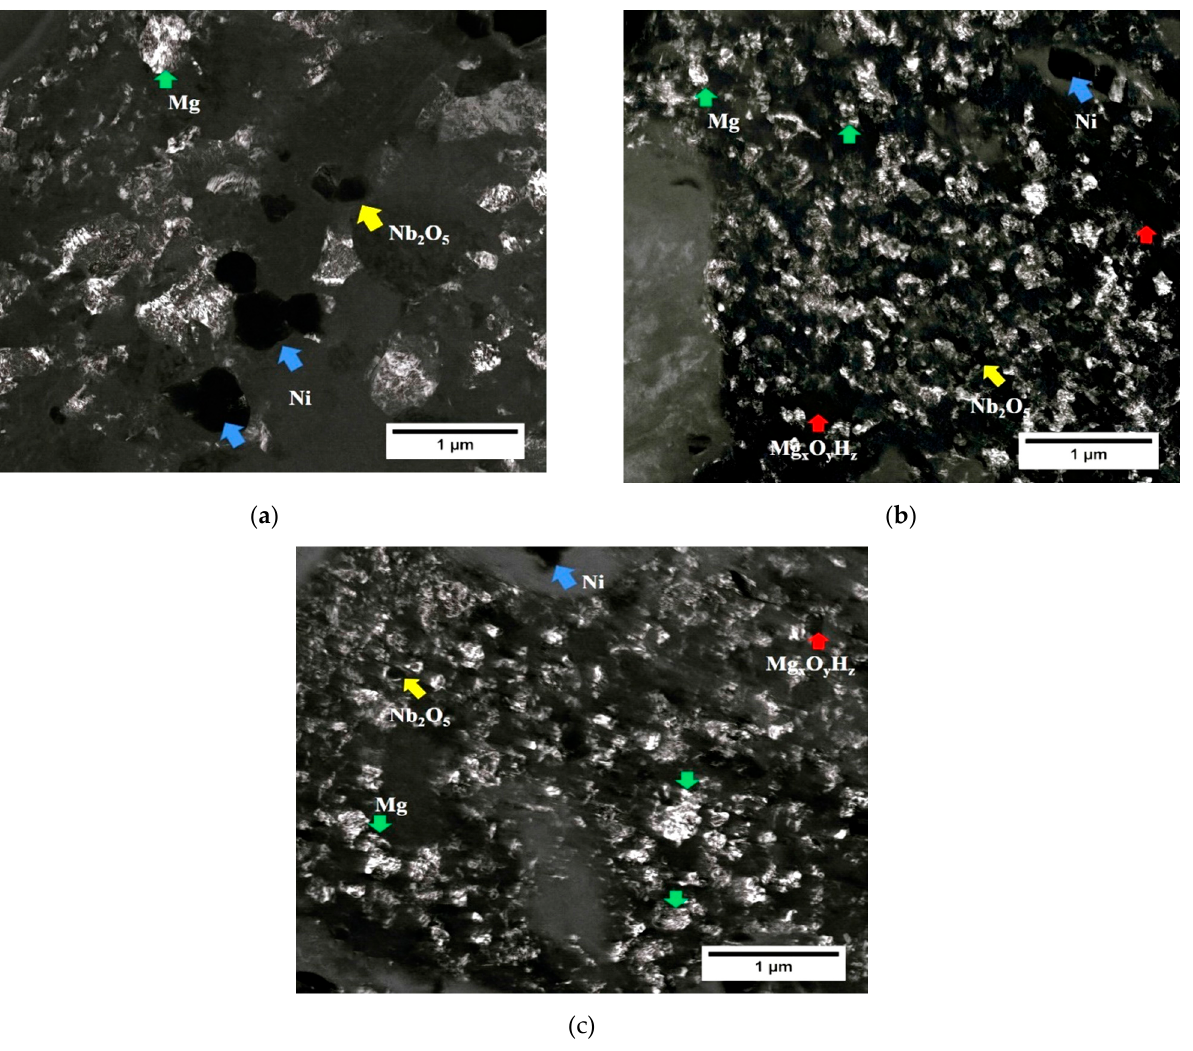
Figure 6. TEM micrographs (dark field) of thin lamellae from samples subjected to ( a ) 5 N, ( b ) 20 N and ( c ) 30 N and under 5 GPa of pressure at locations near the periphery of the disks. Arrows indicate Ni particles (blue), Nb 2 O 5 particles (yellow), Mg x O y H z (red) and Mg grains